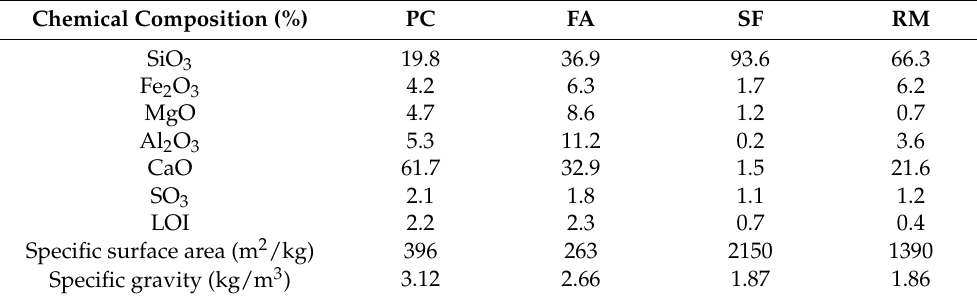
Table 1. Chemical composition and physical properties of the binding materials.